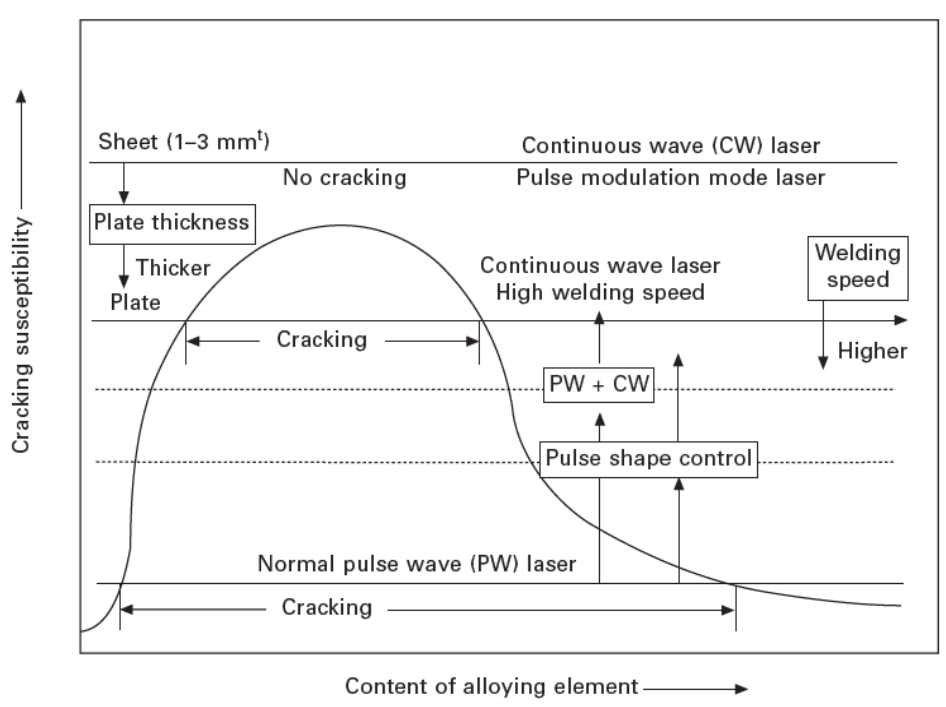
Figure 16. Effect of various factors on solidification cracking of LBW of Al alloys, proposed by Prof. Seiji Katayama [30].